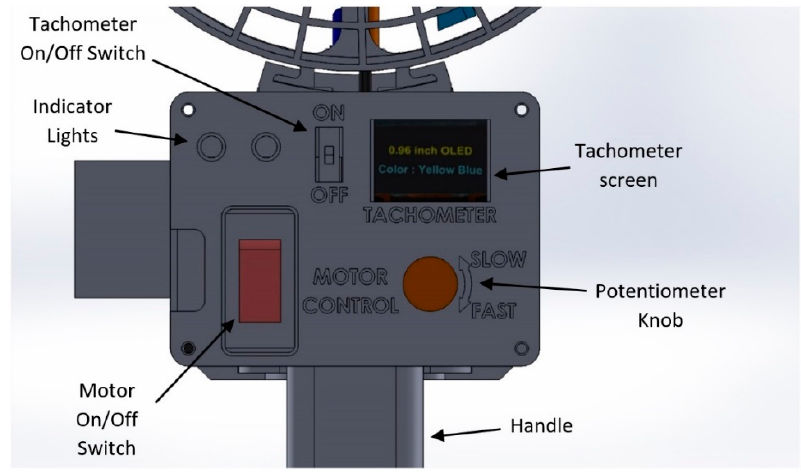
Figure 6. Electronics housing schematic diagram.